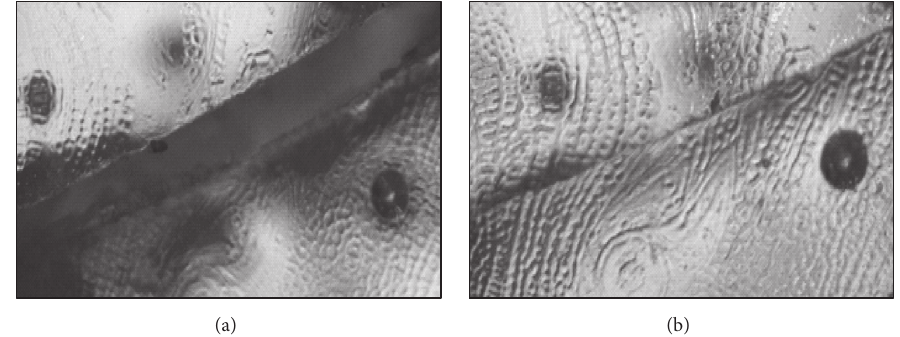
Figure 7: Photographs of the epoxy test specimens with 50 mol% of the thiol-ene system: (a) after the cut in halves and (b) after the healing at 70 ∘ C.